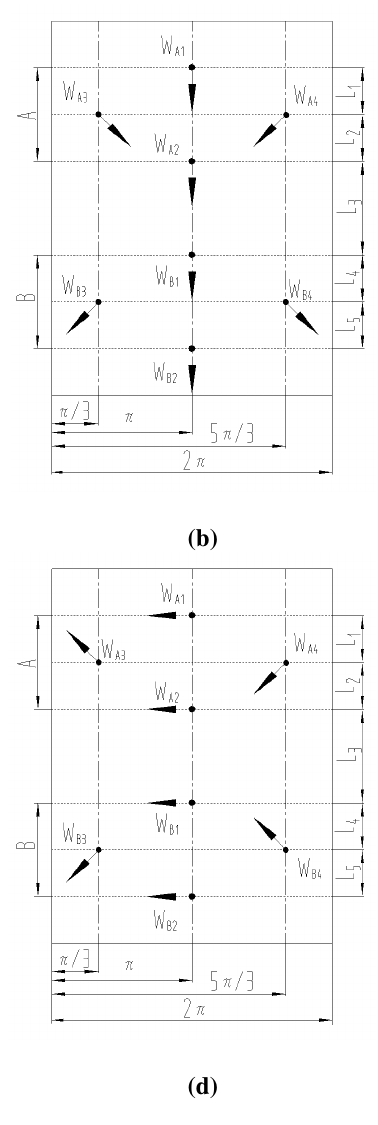
Fig. 7 Velocity vectors of driving wheels walking along the V- and inverted